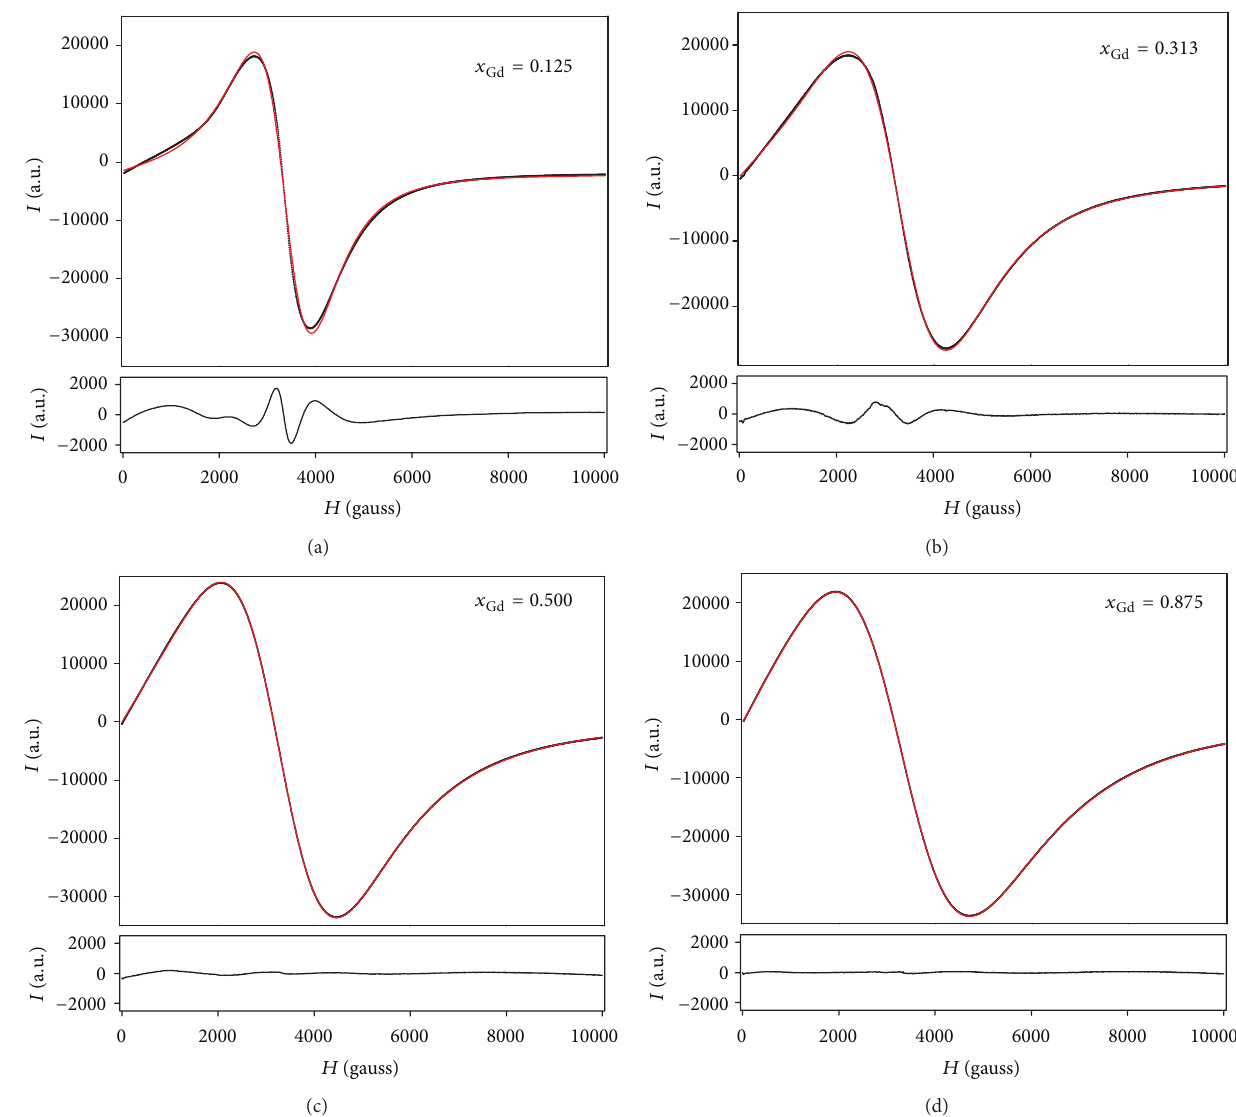
= 0.125 , 0.313, 0.50, and 0.875. Experimental spectra are compared to the fitted Gd